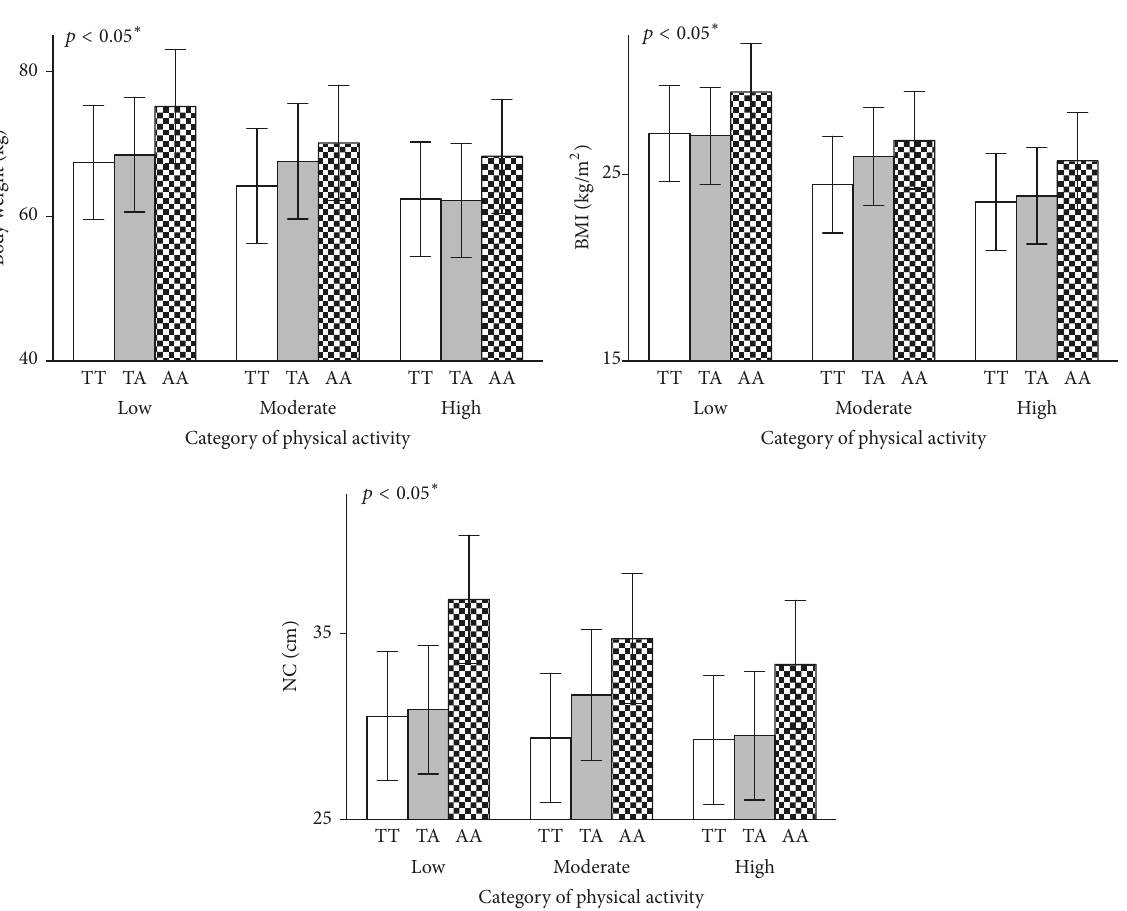
Figure 2: Effect of the FTO rs9939609 genotype on adiposity measures (body weight, BMI, and NC) stratified by category of PA. 𝑝 values are for the interaction between the FTO variant and PA category; least-squares means of different genotypes across all PA groups were calculated usingRobustLinearRegressionanalysis,afteradjustingforageandsex.AllelefrequencybyPAcategorywaslow:20/43/14;moderate:28/34/13; high: 27/13/9 for TT, TA, and AA genotypes, respectively. BMI: body mass index; NC: neck circumference. ∗ Mean of each variable with genotype for high PA is different from mean of each genotype for low PA at 𝑝 < 0.05 but not in NC TA and TT